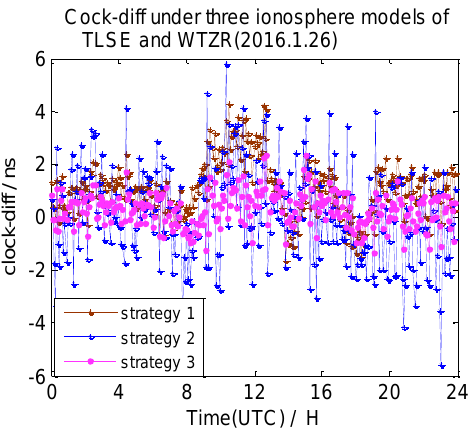
Figure 15. The clock difference under three ionosphere methods of TLSE and WTZR.